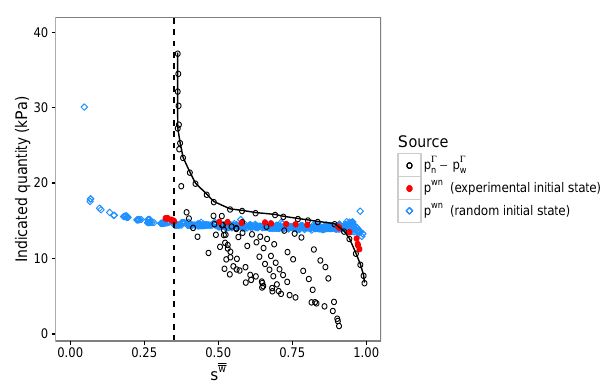
Figure 2. Comparison between the experimentally measured boundary pressure difference p (cid:48) n − p (cid:48) w and the capillary pres- sure p wn for the micromodel geometry. The solid line represents the boundary pressure along primary